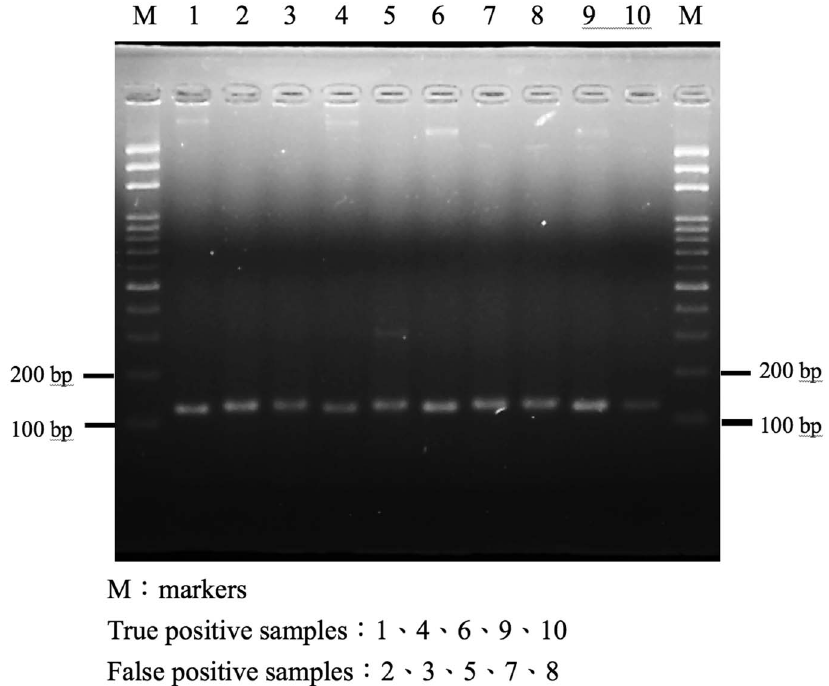
Figure 2. Gel electrophoresis of PCR products by RT-PCR amplification of RdRp gene in true-positive samples and false-positive samples. Footnote of Figure 2: The 5 true-positive samples were confirmed by viral protein 1 gene amplificaion and sequence of amplicons. In the 5 false-positive samples, the amplicon sequences were belonged to human DNA.